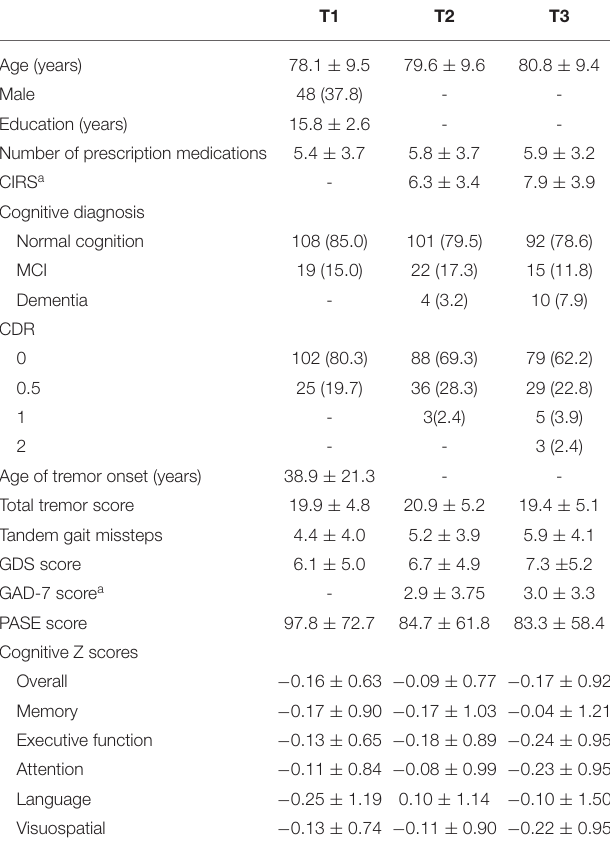
TABLE 2 | Relationship between baseline variables and baseline PASE. Correlation coefficient with baseline PASE ( r )